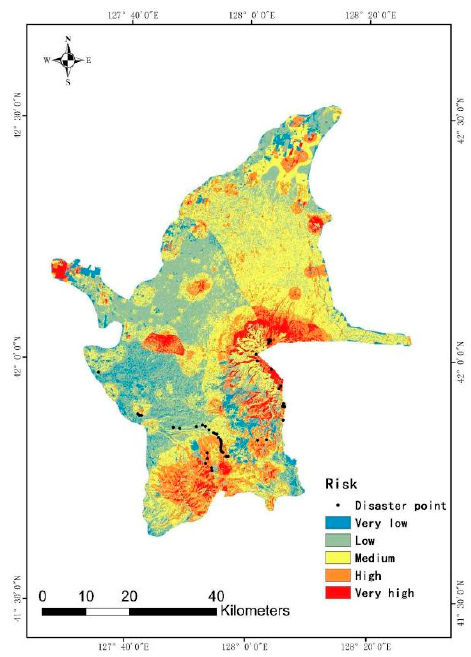
Figure 10. Earthquake landslide disaster risk maps.